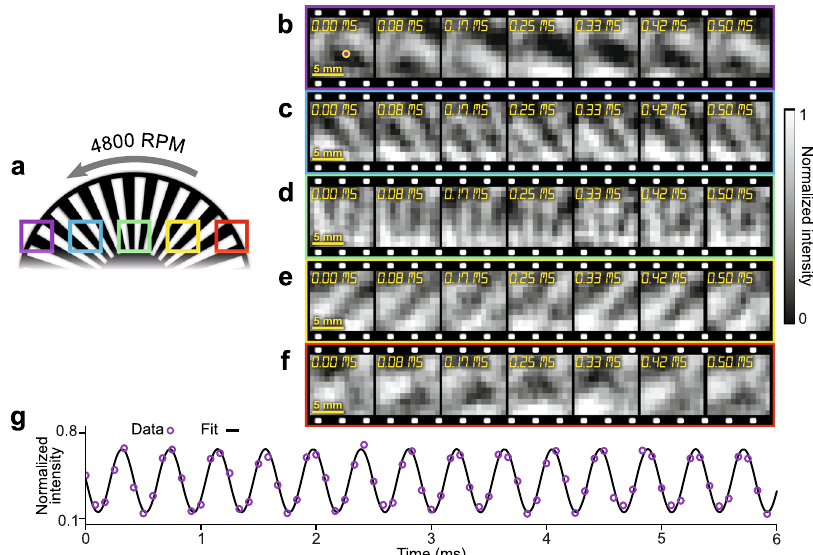
Fig.6|Ultrahigh-speedSPI-ASAPofanopticalchopperrotatingat4,800RPM. a Schematic of the experimental setup. Color boxes show regions imaged by SPI- ASAP. b – f Consecutiveframesofreconstructedultrahigh-speedvideoswithoutline